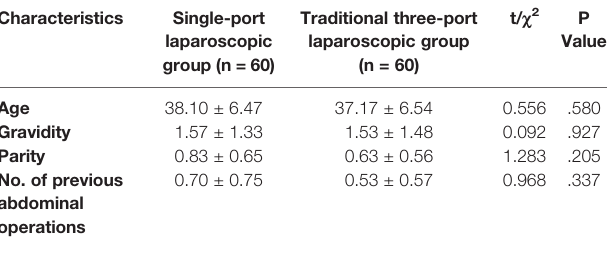
TABLE 1 | Clinical characteristics of the patients in single-port laparoscopic group and traditional three-port laparoscopic group. Characteristics